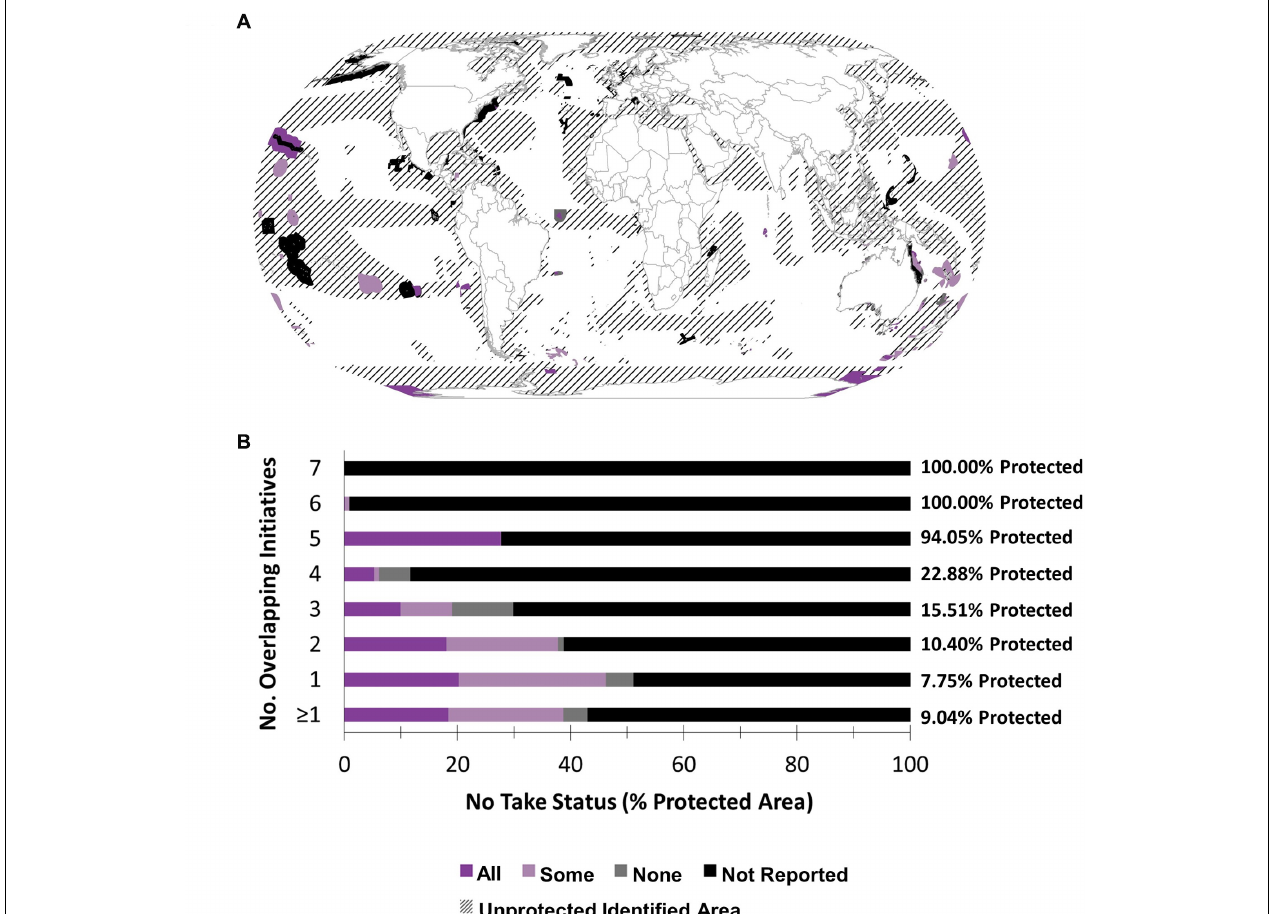
FIGURE 3 | Map showing the protection level of areas identified as important based on the World Database on Protected Areas (UNEP-WCMC and IUCN, 2019b). Identified areas outside of marine protected areas (MPAs) are shown using hatching and areas within MPAs are colored based on their no-take status (A) . Areas were identified as important by six United Nations and four non-governmental organization initiatives that vary in purpose and scope. The percent protection at each level of overlap and the no-take status of this protection is shown in (B) . As the number of overlapping initiatives in an area increased, so did the likelihood that the area was already within an MPA (B) . However, only 18.4% of all identified area that was protected fell within no-take MPAs and the no-take status of many protected identified areas was unknown (A,B) . Countries are displayed using data provided by Natural Earth (Admin 0 Countries 4.1.0; Natural Earth, 2018a).